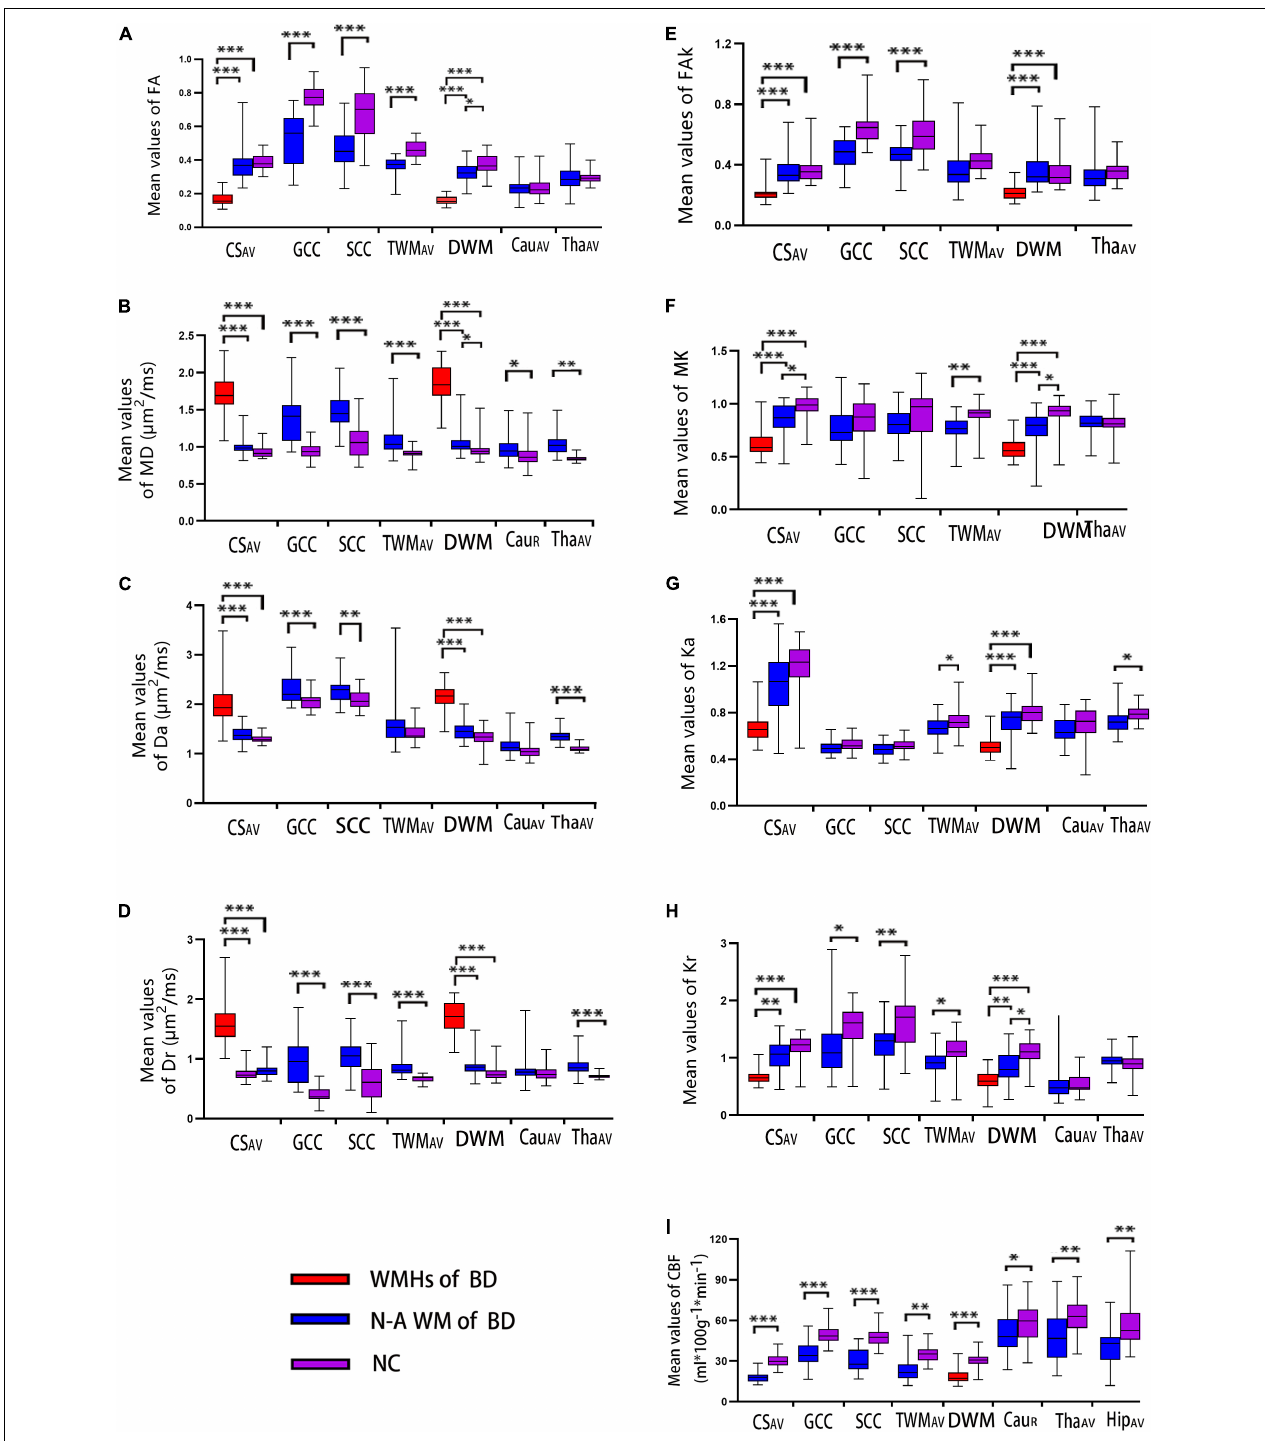
FIGURE 2 | Box and whiskers graphs of DKI measurements ( A–I represent the FA, MD, Da, Dr, FAk, MK, Ka, and Kr, respectively.) among the three groups (WMHs of BD, WM normal-areas of BD, and NC) and ASL measurement (CBF) between BD and NC groups over different subregions of the brain. The solid line inside the box represents the median value, whereas the edges represent the 25th and 75th percentiles. A straight line (bar) on each box indicates the range of data distribution. BD, Binswanger’s disease; WMHs of BD, white matter hyperintensities of patients with BD; N-A WM of BD, white matter normal areas of patients with BD; NC, healthy control; R, the right-hemispheric side; AV, average of bilateral ROI measurements; CS, centrum semiovale; GCC/SCC, genu/splenium of the corpus callosum; DWM, deep white matter, including the frontal/parietal white matter and the WM around bilateral ventricle (in the figure, bilateral ventricle around frontal WM is used as the representative area of DWM); TWM, temporal white matter; Cau, caudate nucleus; Tha, thalamus; Hip, hippocampus. Significant difference: ∗ p < 0.005; ∗∗ p < 0.001; ∗∗∗ p < 0.0001.